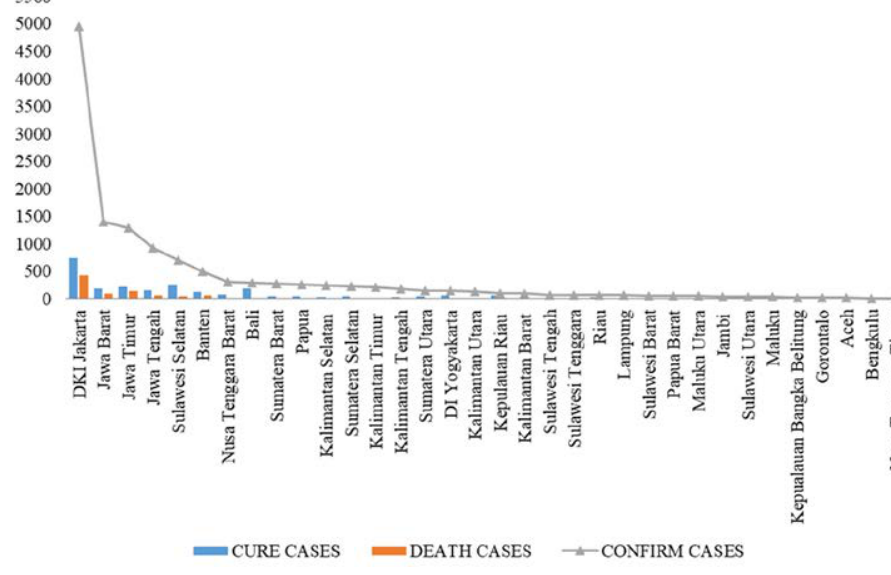
Fig. 1. Distribution of COVID-19 cases in 34 provinces of Indonesia